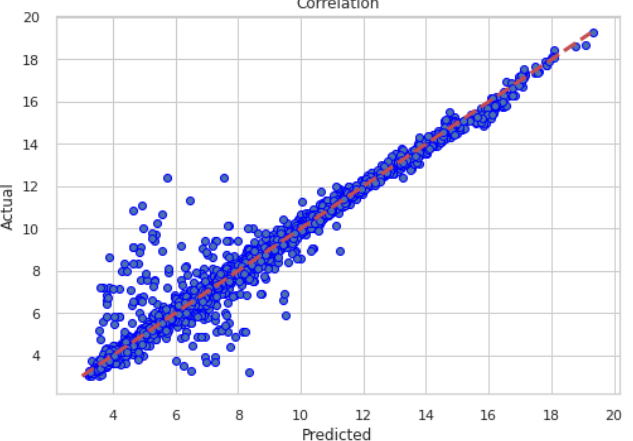
Figure 8. Correlation between observed (measured) data and results from the RF trained only with observed data in ms − 1 .